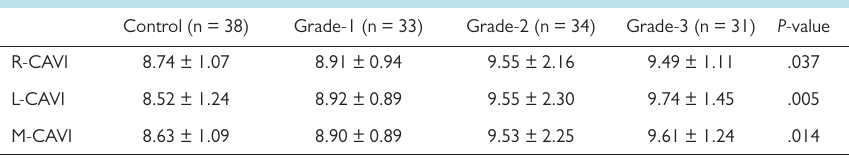
Table 2. Right, Left, and Mean CAVI According to MAC-Positive Grades and Control Group Control (n = 38)